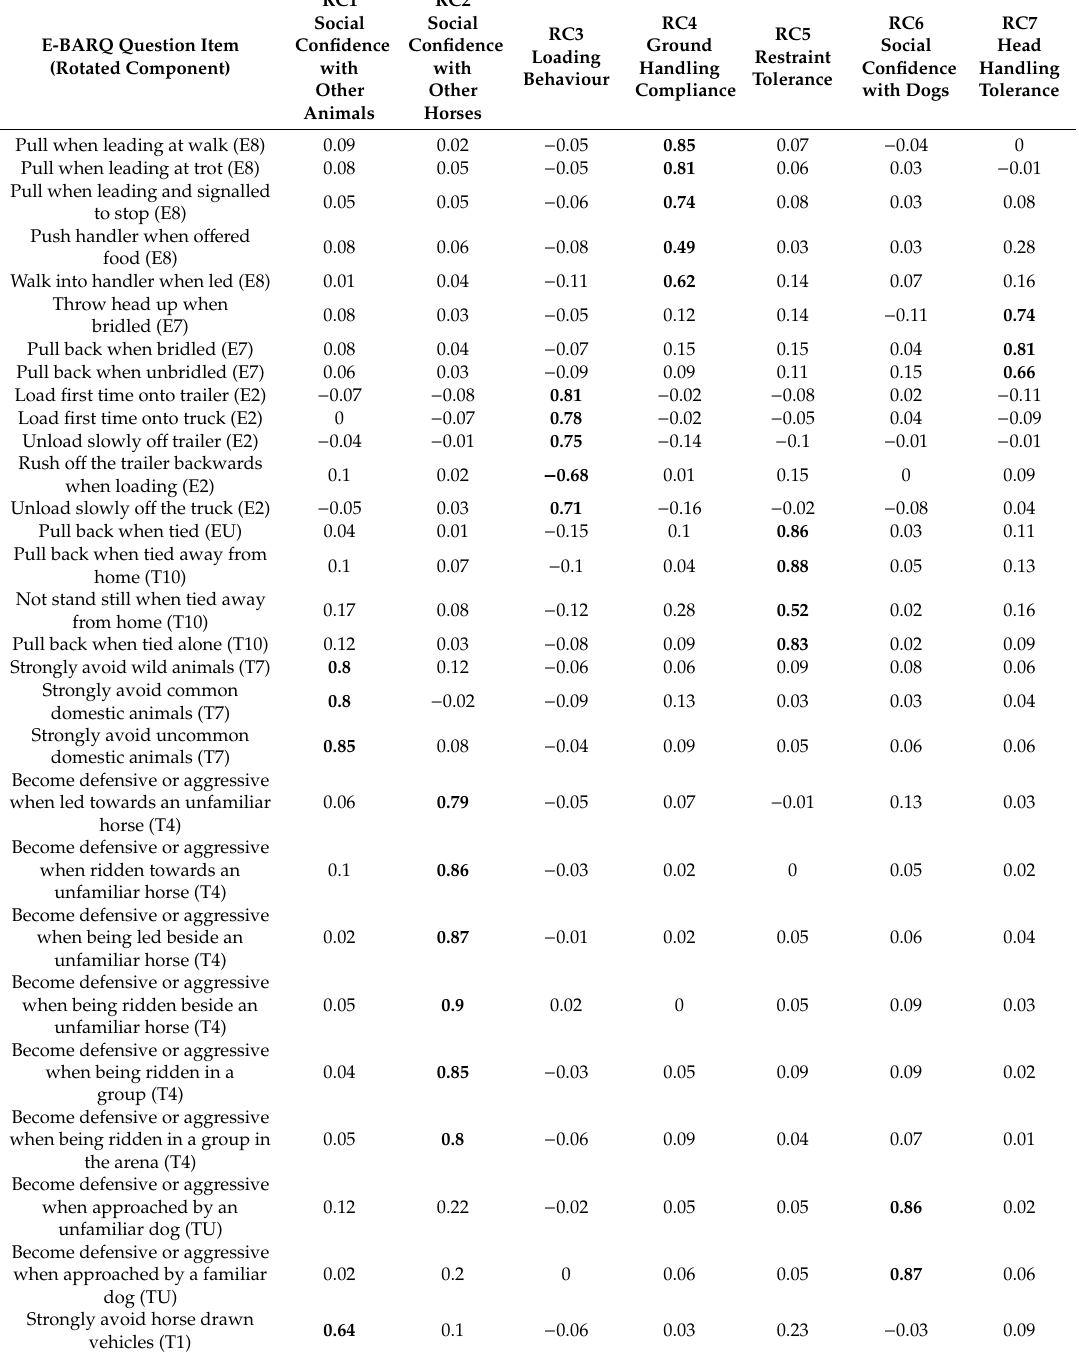
Table 2. Parallel analysis of 29 independent predictor indices with loading values displayed. Values > 0.49 were combined to form the seven underlying rotated components (RC) (grouping appear in